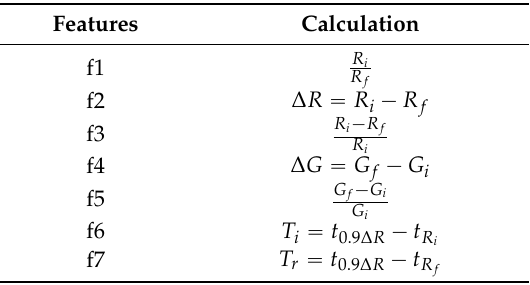
Table 2. Features extracted from sensors